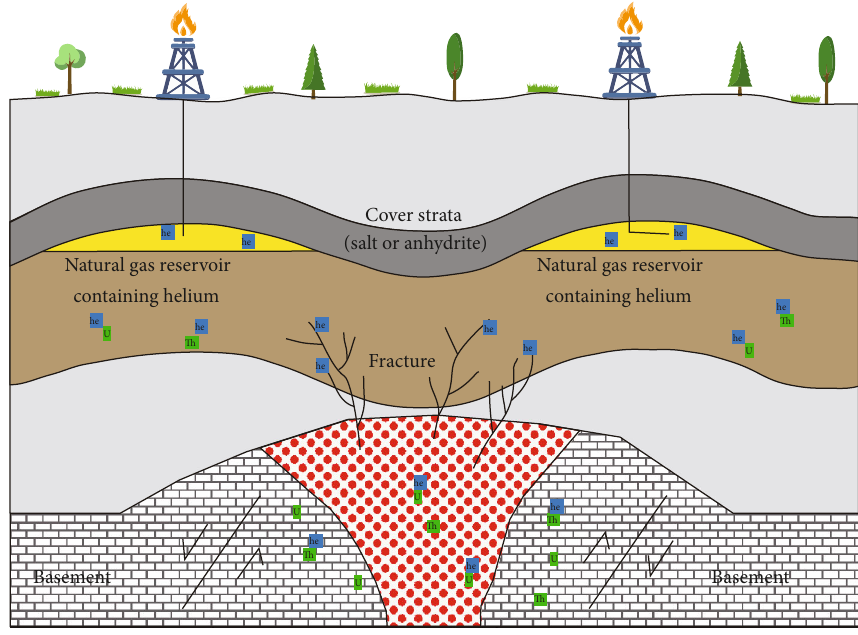
Figure 5: Migration and accumulation model of helium. Table 1: Industrial standards for helium-bearing gas fi elds